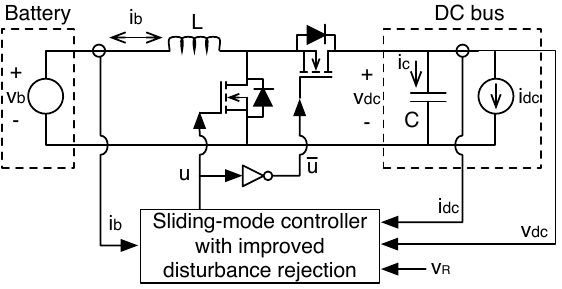
Figure 5. Proposed structure of a sliding-mode controller with improved disturbance rejection for the